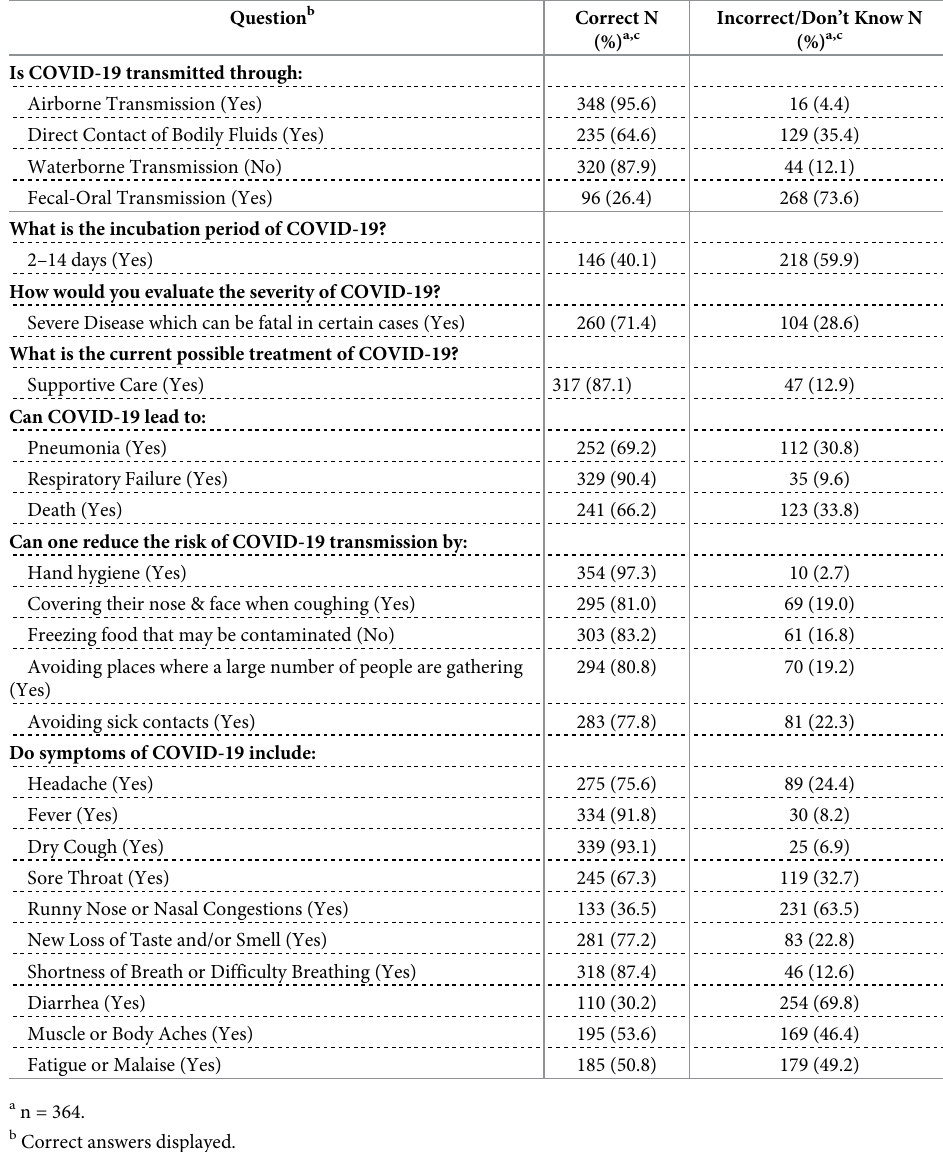
Table 3. Knowledge of COVID-19 among Somali healthcare